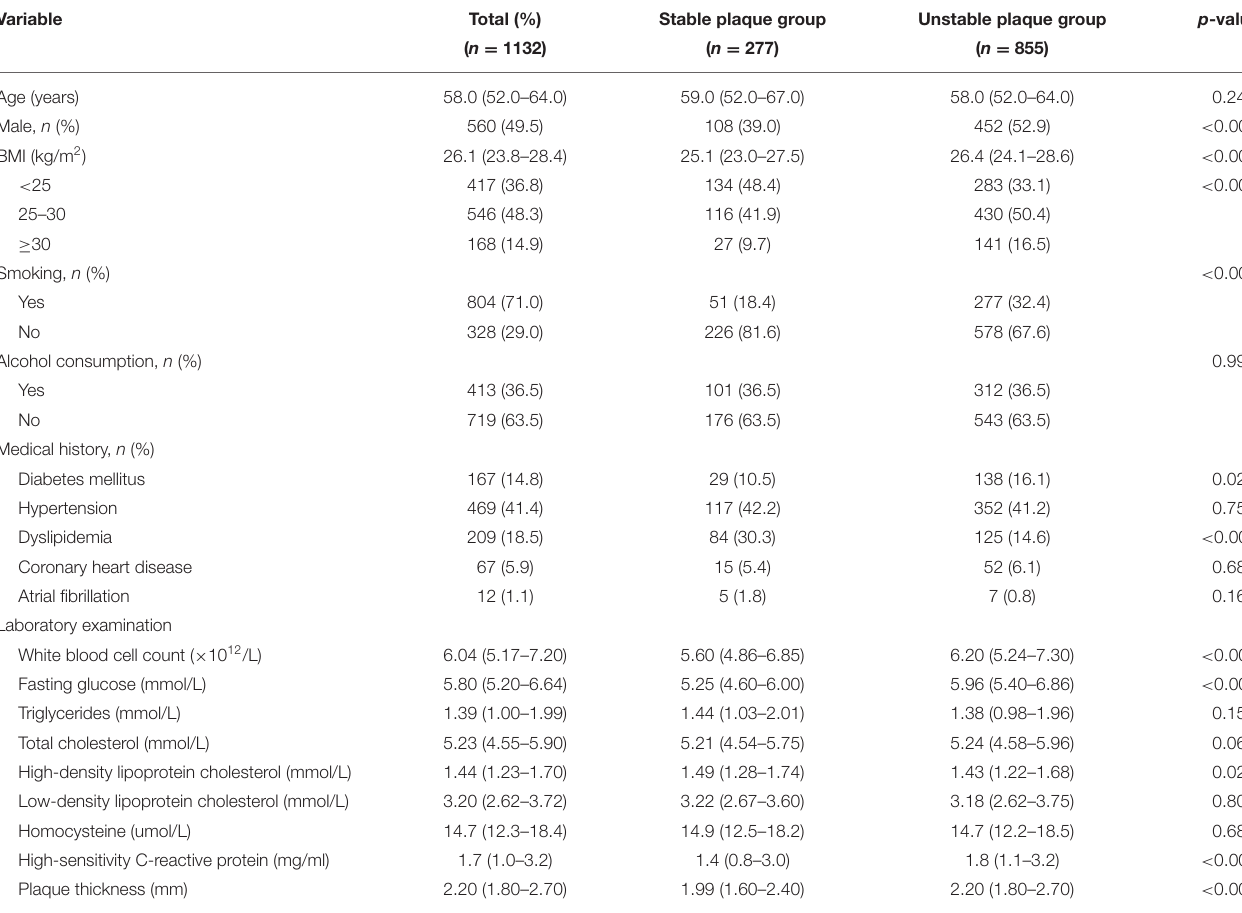
TABLE 1 | Comparison of clinical data between stable and unstable plaque groups. Variable